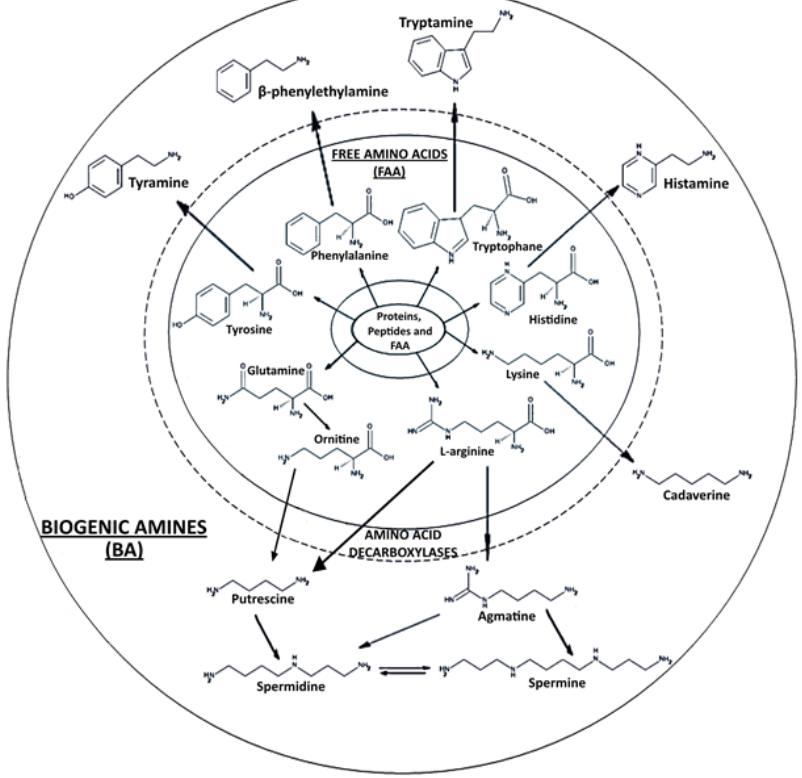
Figure 1. Biogenic amine formation from free amino